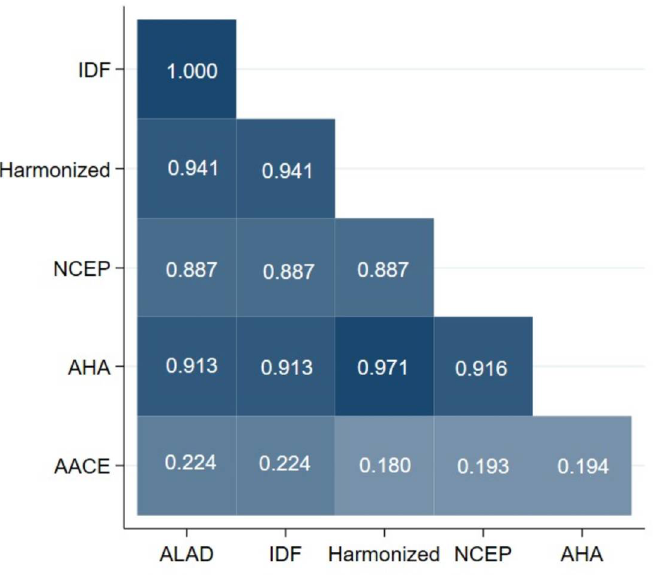
Figure 2. Heatplot of metabolic syndrome diagnostic criteria in men. ALAD: Latin American Consensus of the Latin American Diabetes Association; IDF: International Diabetes Federation; NCEP-ATP III: National Cholesterol Education Program-Adult Treatment Panel III; AHA/NHLB: American Heart Association/National Heart, Lung, and Blood Institute Scientific Statement; AACE: American Association of Clinical Endocrinologists.